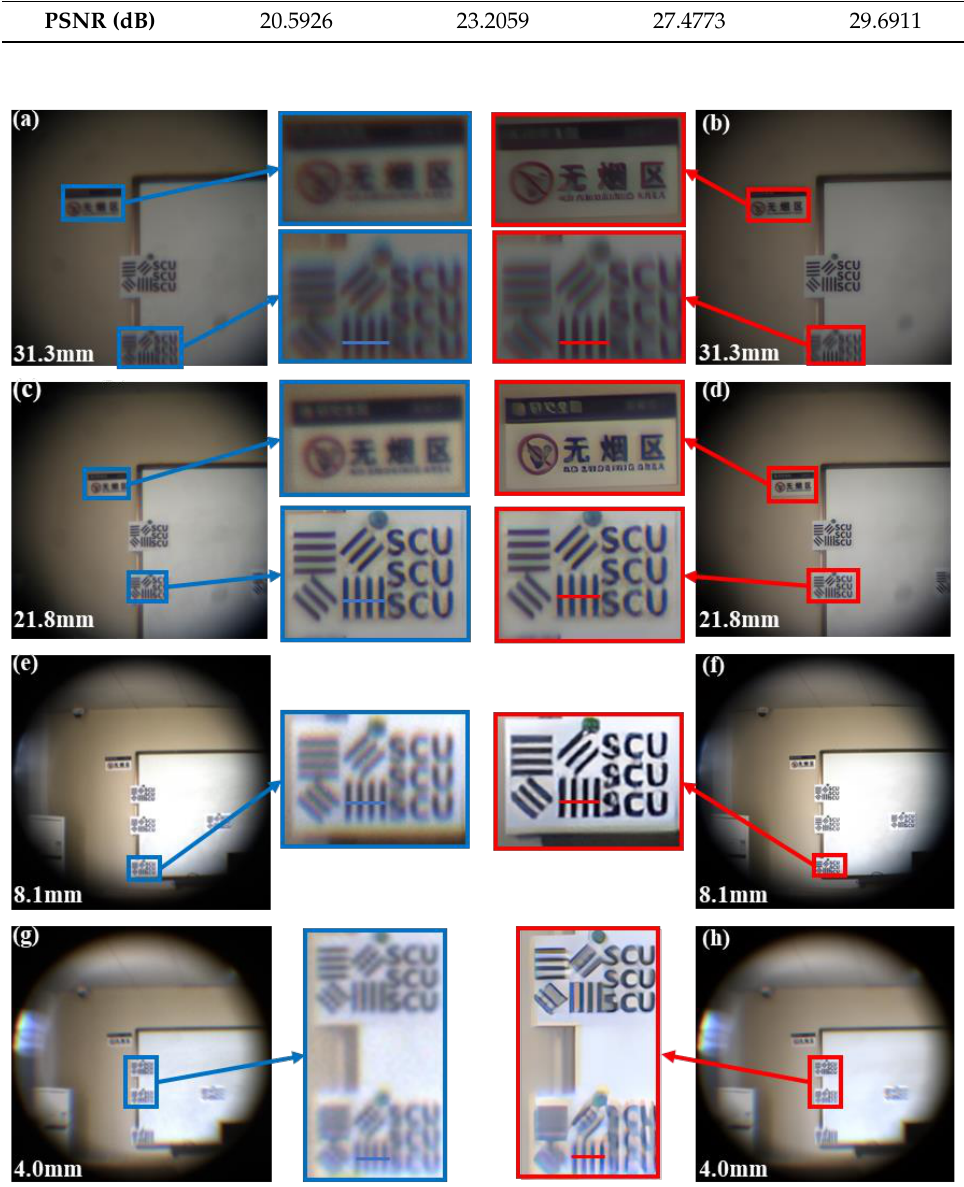
Figure 6. Comparison of image quality of resolution targets. ( a ) Image taken at f = 31.3 mm without deep learning. ( b ) Image processed at f = 31.3 mm by deep learning. ( c ) Image taken at f = 21.8 mm without deep learning. ( d ) Image processed at f = 21.8 mm by deep learning. ( e ) Image taken at f = 8.1 mm without deep learning. ( f ) Image processed at f = 8.1 mm by deep learning. ( g ) Image taken at f = 4.0 mm without deep learning. ( h ) Image processed at f = 4.0 mm by deep learning. From the experiments, the proposed zoom system can achieve a large adjustable focal length range from 4.0 mm to 31.3 mm, together with high-resolution images. In addition, only voltages are used to zoom, without moving parts. Therefore, the proposed zoom system is very compact and easy to